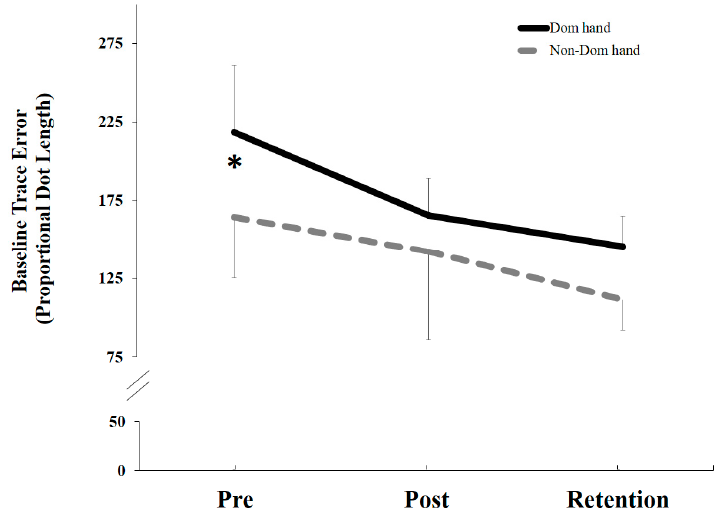
Figure 5. Average percentage error differences for pre-acquisition (baseline), post-acquisition and retention for both groups (Dom vs. Non-Dom). The Non-Dom group was significantly more accurate at baseline, relative to the Dom group (* p < 0.0001). Error bars represent SD.